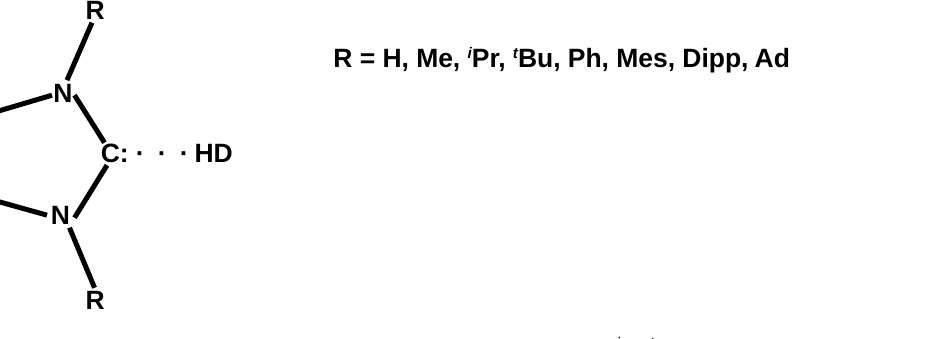
Figure 1. General scheme of the IR 2 · · · HD dimers (R = H, Me, i Pr, t Bu, Ph, Mes, Dipp, Ad). The colon on the carbene carbon atom represents a lone electron